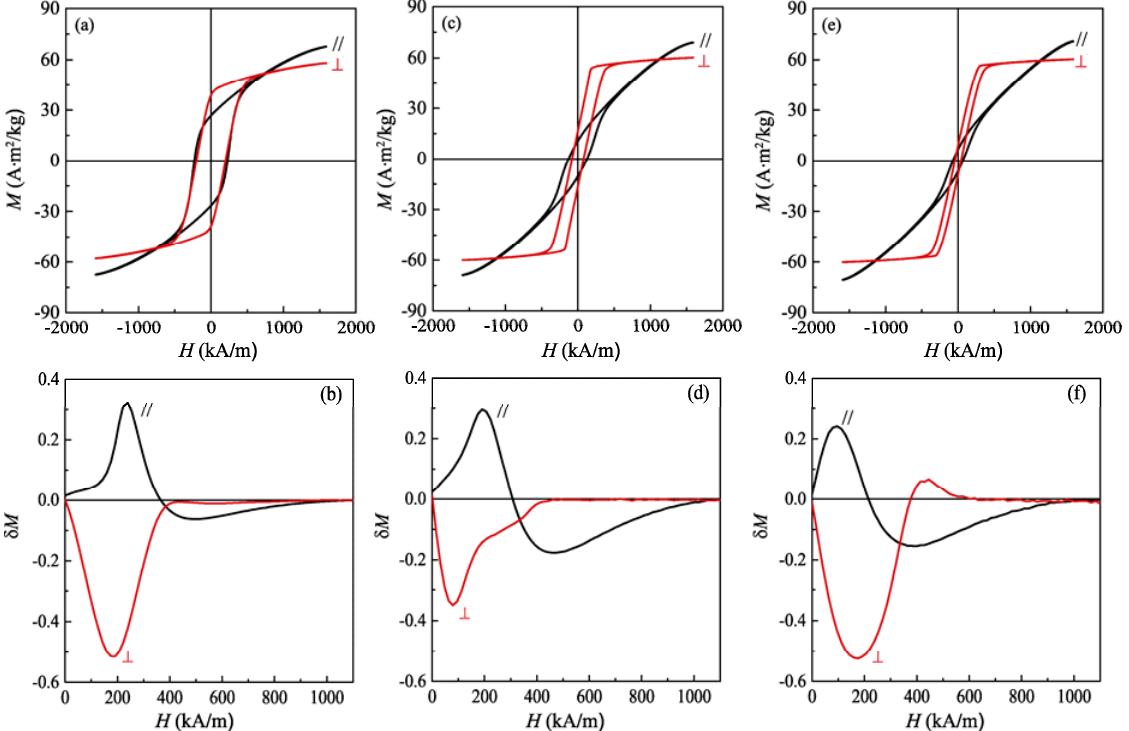
Fig. 4 (a, c, e) Magnetic hysteresis loops and (b, d, f) Henkel plots of sintered SrM specimens. Note: T s is 1100 ℃ in (a, b), 1150 ℃ in (c, d), and 1250 ℃ in (e,